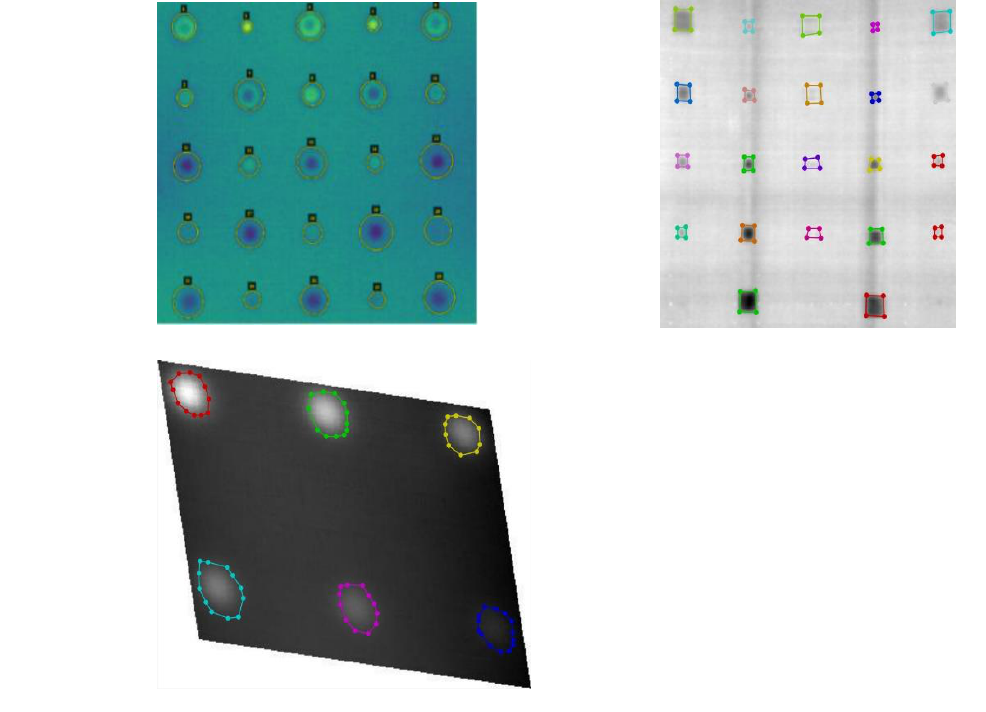
Figure 7. Labels for preprocessed sample image.